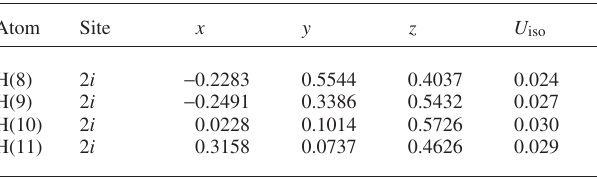
Table 2. Atomic coordinates and displacement parameters (in Å 2 )